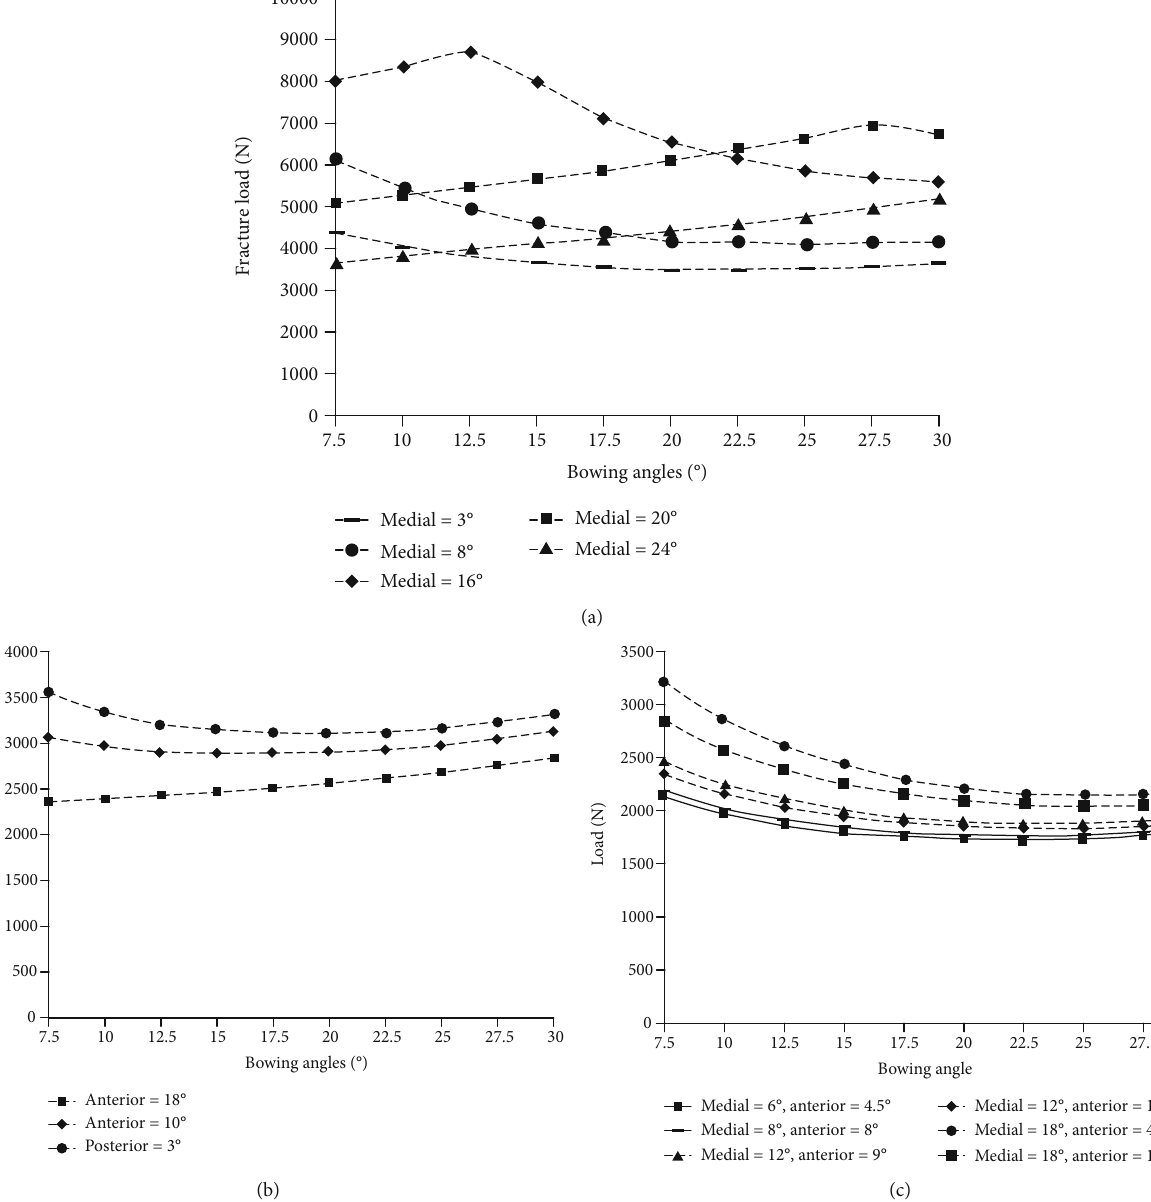
Figure 5: (a) Fracture load in the frontal plane; (b) fracture load in the sagittal plane; (c) fracture load in the frontal and sagittal